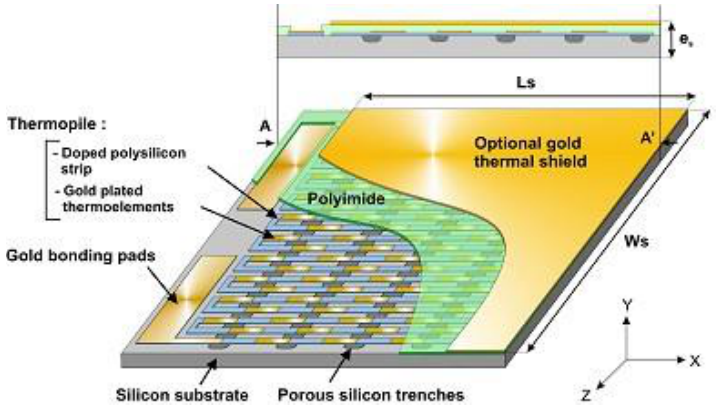
Figure 2. Schematic diagram of the heat flux microsensor.